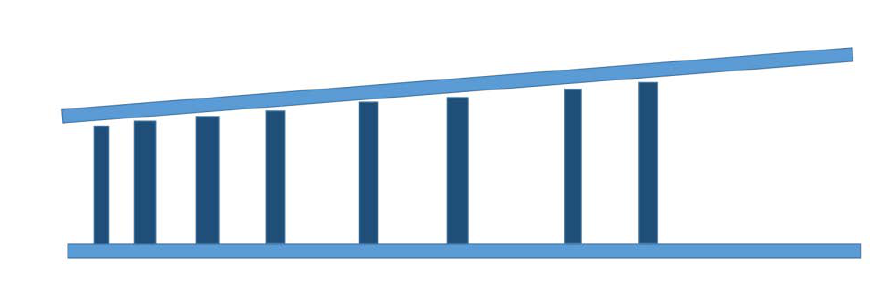
Fig. 5 distribution of measured height of 20 tubular spacers.